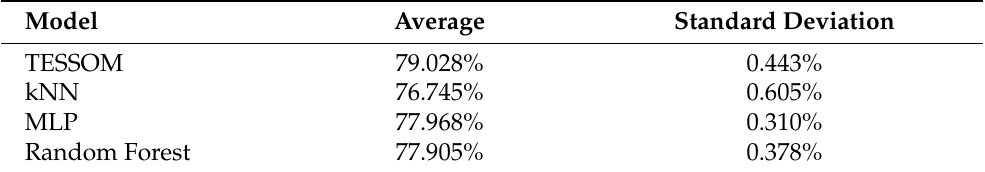
Table 8. Accuracy comparison—models trained with the complete dataset.